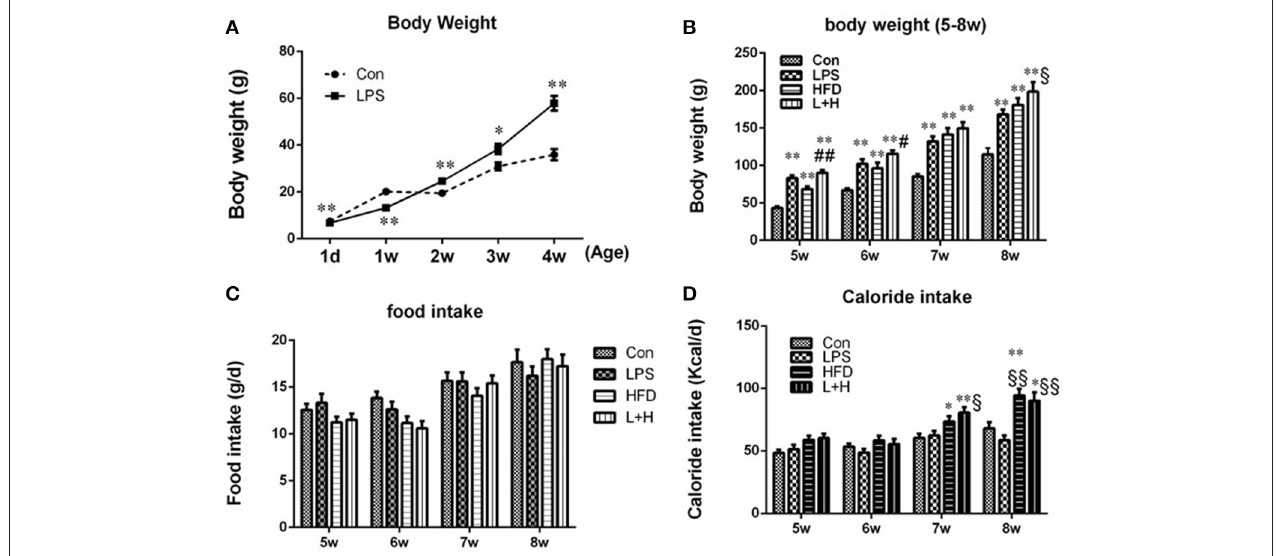
FIGURE 1 | Body weights in offspring rats at the age of 1 day, 1, 2, 3, and 4 weeks (A) . Body weights in offspring rats from 5 to 8 weeks old (B) . Food intake (C) and caloride intake (D) in offspring rats from 5 to 8 weeks old. The data are presented as the mean ± SEM. n = 10 in each group. * P < 0.05, ** P < 0.01 vs. control, § P < 0.05, §§ P < 0.01 vs. LPS group, # P < 0.05, ## P < 0.01 vs. HFD group (One-way ANOVA). Con group, male offspring rats treated with prenatal saline and postnatal normal diet from 4 to 8 weeks old; LPS group, male offspring rats treated with prenatal LPS and postnatal normal diet from 4 to 8 weeks old; HFD group, male offspring rats treated with prenatal saline and postnatal high fat diet from 4 to 8 weeks old; L + H group, male offspring rats treated with prenatal LPS and postnatal high fat diet from 4 to 8 weeks old.